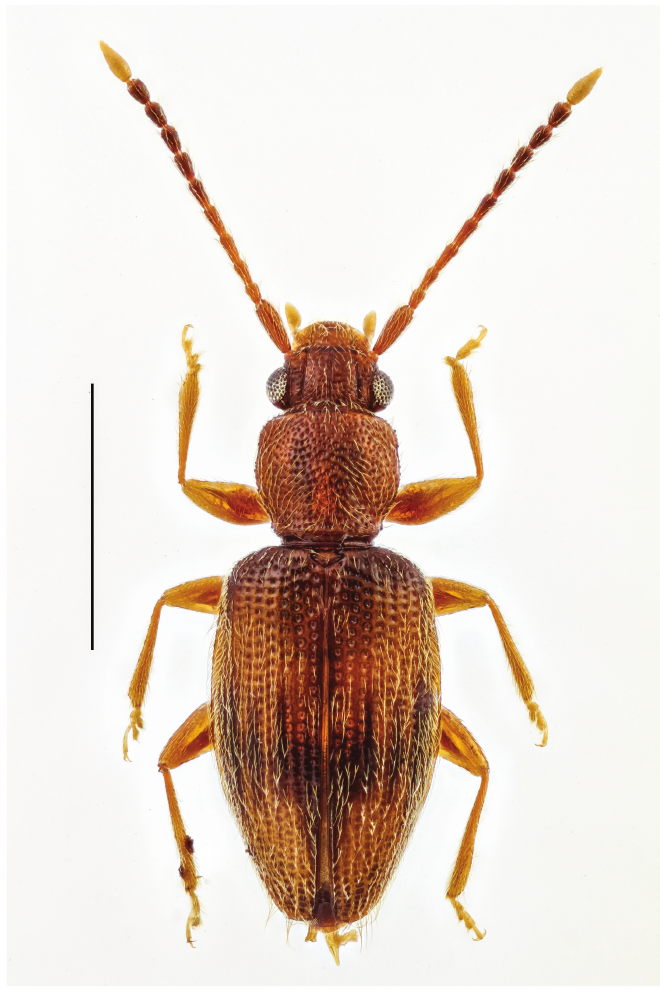
Fig. 1. Bolianus giannae gen. et sp. nov., holotype, habitus. Scale bar =